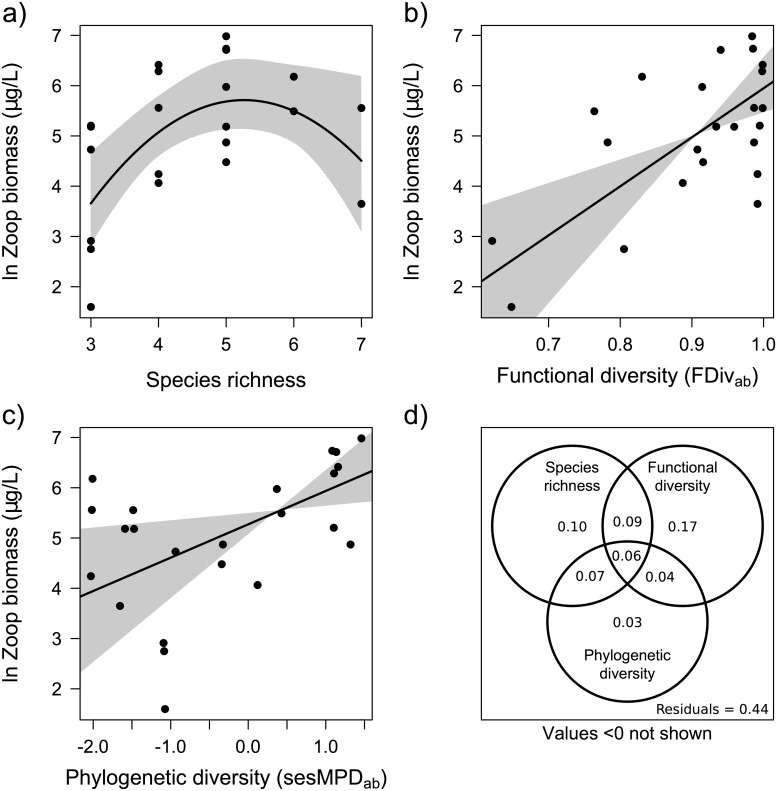
Zooplankton community biomass in the 23 ponds as predicted by the best diversity indices in each category: taxonomic diversity—species richness (a), functional diversity—abundance weighted functional divergence (b), phylogenetic diversity—abundance weighted standard effect size mean pairwise distance (c), and the variation partitioning for these three models with their adjusted R2 (d).Significant model trends are shown as black lines. The grey bands indicate the 95% confidence intervals for the predicted values (a) and the slope of the regression lines (b,c).